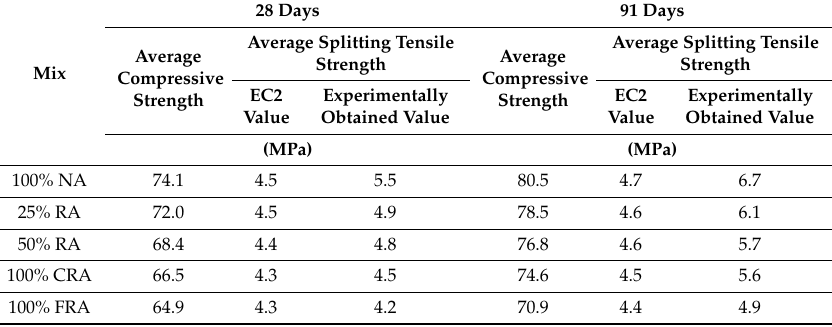
Figure 7. ( a ) Splitting tensile strength versus compressive strength in cylindrical specimens at 28 and 91 days (PC 65); ( b ) Splitting tensile strength versus compressive strength in cylindrical specimens at 28 and 91 days (PC 45). Table 8. Splitting tensile strength versus compressive strength determined according to EC2 [32] at 28 and 91 days (PC 65).